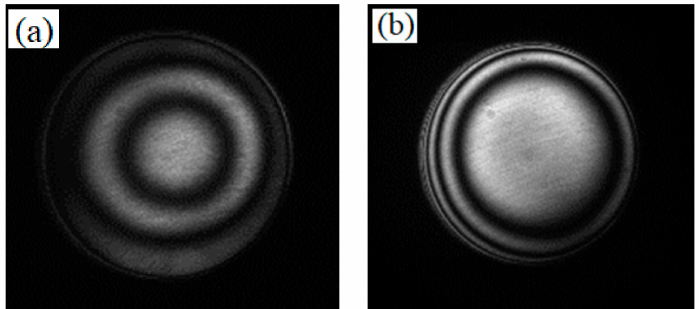
Figure 5. Interferogram of 9-layer notch filter ( a ) substrate before coating; ( b ) substrate after